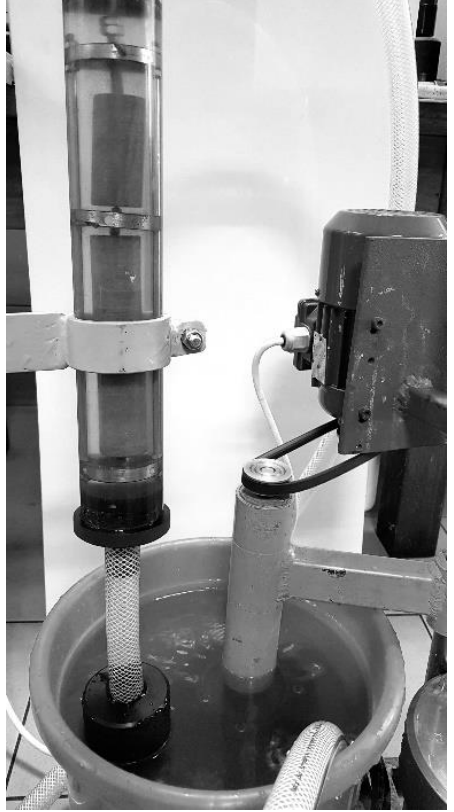
Figure 2. Drilling fluid flow simulator-view of the spacer pumping device. In the first stage, the degree of surface cleaning of the cores was determined by measuring the mass of the mud cake remaining on the cores after washing. The cores reflect the annular space of the borehole. The mass of the core before mud cake formation ( m R ) was determined, then the core with the mud cake ( m Ros ) was weighed, and after pumping the spacer, the weight of the rock core with the residue of the spacer was determined again after pumping the spacer ( m Rpo ). On the basis of the obtained results, the percentage effectiveness of the mud cake removal from the core surface was calculated according to